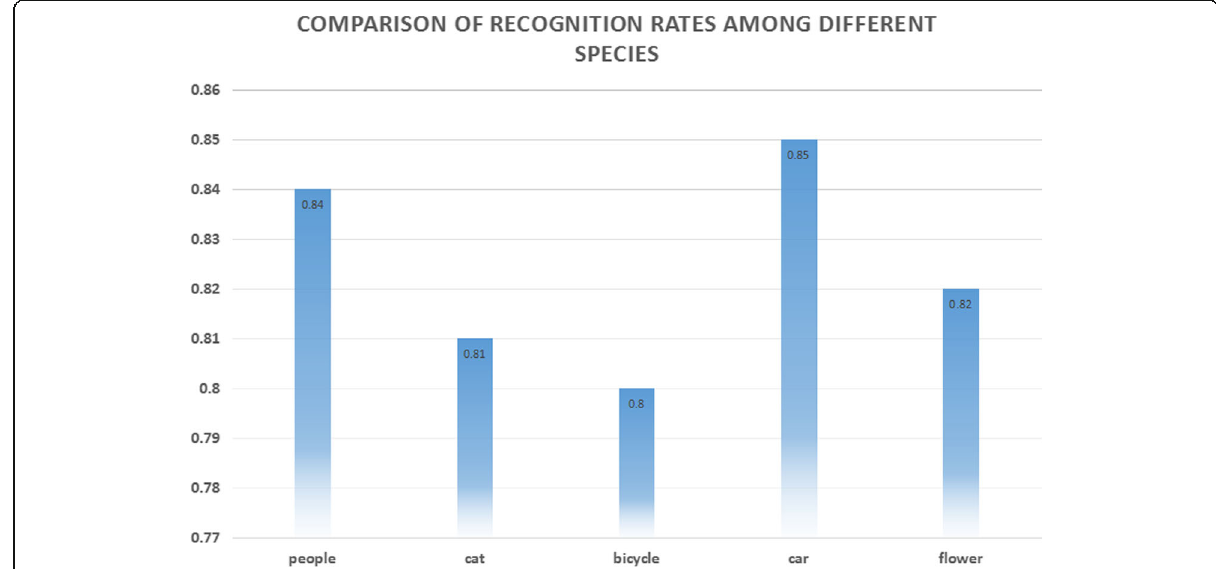
Fig. 5 Comparison of recognition rates among different